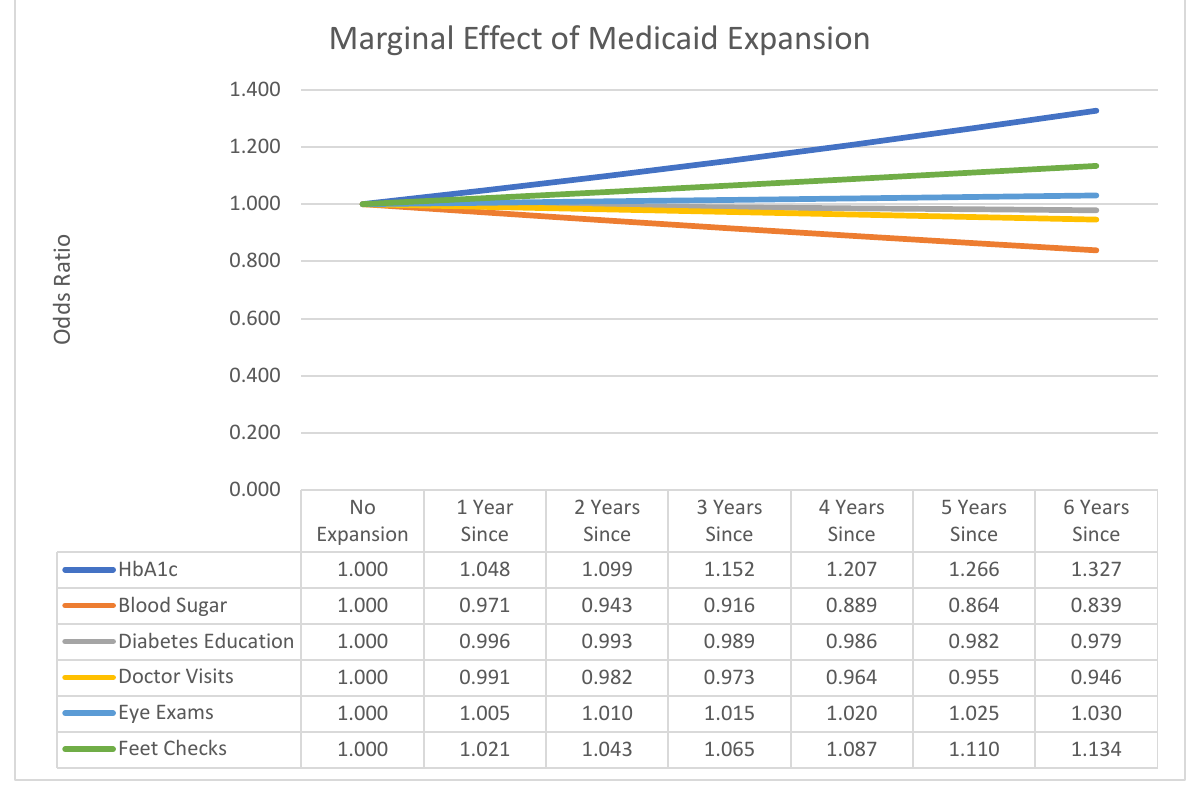
Figure 7. Marginal effects of Medicaid Expansion.